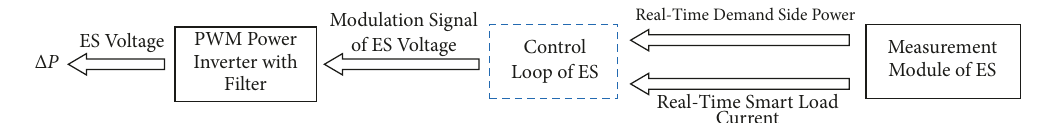
Figure 7: The flowchart of using ES to restrain the fluctuation of demand side power in